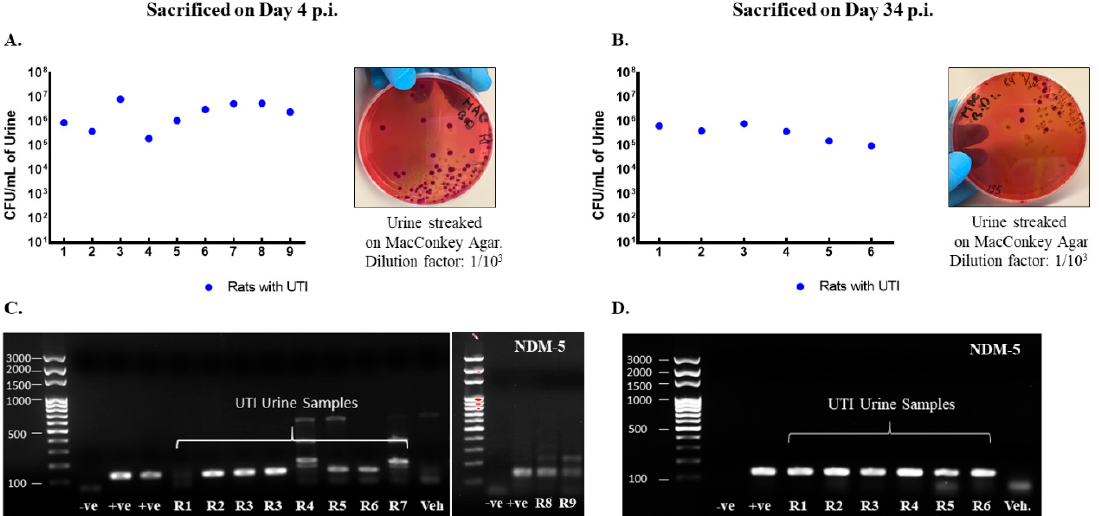
Figure 2. Rats with a UTI confirmed for infection by the presence of NDM − 5 bacterial-specific gene in urine and CFU/mL > 10 5 . CFU/mL of urine samples collected on day 1 post infection from rats with a UTI that were either sacrificed on day 4 ( n = 9) ( A ) or day 34 ( n = 6) ( B ) post infection along with representative images for the streaked MacConkey agar plates. Each dot represents the CFU/mL value for one rat. All rats had a CFU/mL value above 10 5 confirming infection. Presence of Ndm − 5 gene in urine samples collected on day 1 post infection as confirmed by conventional PCR and shown by gel electrophoresis for rats with a UTI sacrificed on day 4 post infection ( C ) and day 34 post infection ( D ).